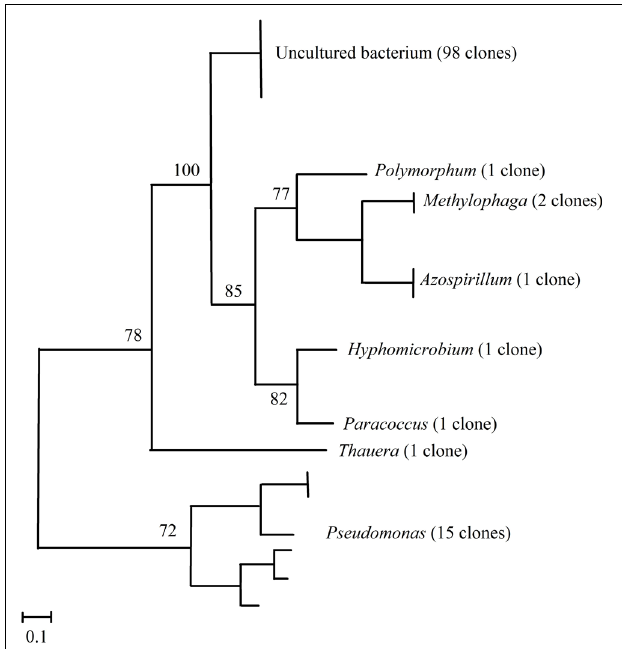
FIGURE 2 | Neighbor-joining phylogenetic tree based on partial nosZ sequences of clones isolated from sediments of La Caldera lake (Sierra Nevada, Spain). The analysis was based on 250 nucleotides. Bootstraps values are indicated as percentages derived from 1000 replications. Values lower than 70 are not shown. Bar, 0.1 nucleotide substitution per 100 nucleotides.